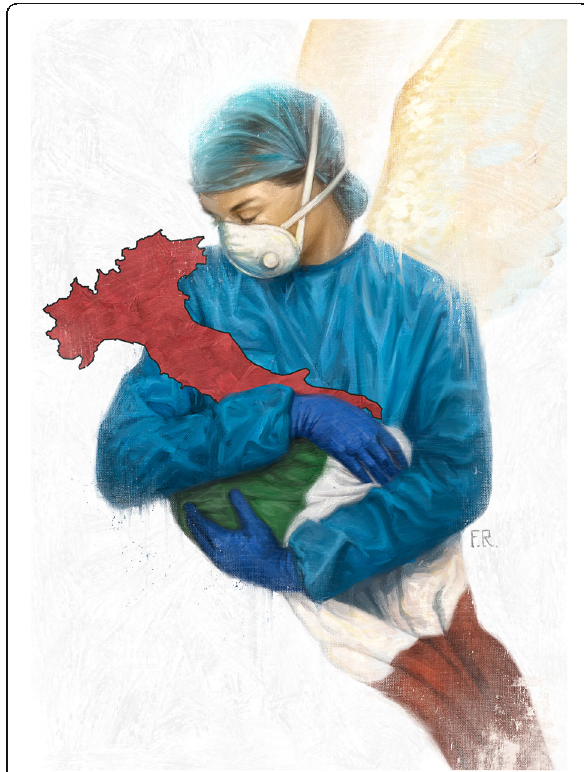
Fig. 1 “ Angels ” by Franco Rivolli. Reproduced with permission